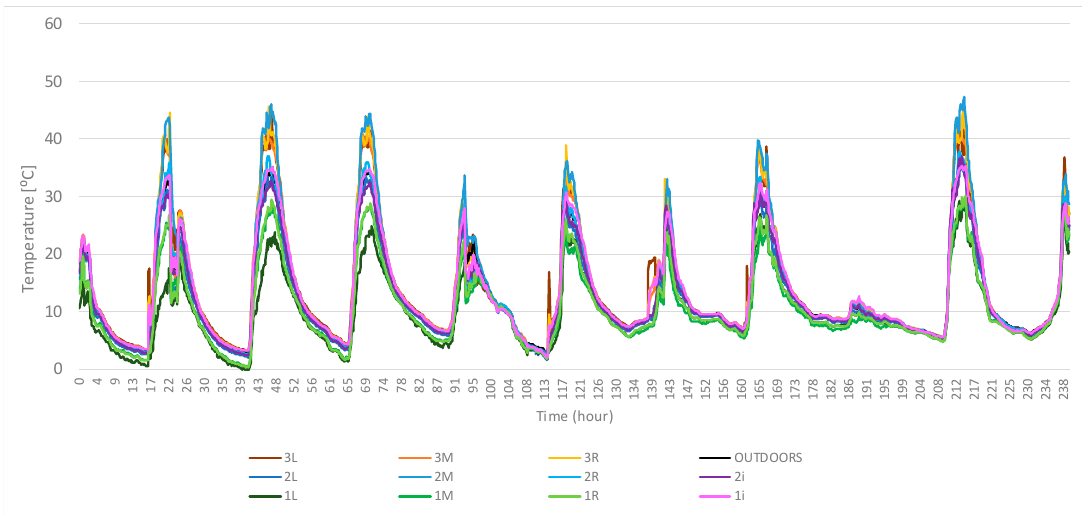
Figure 5. Outdoor, indoor and façade temperatures registered from 18–20